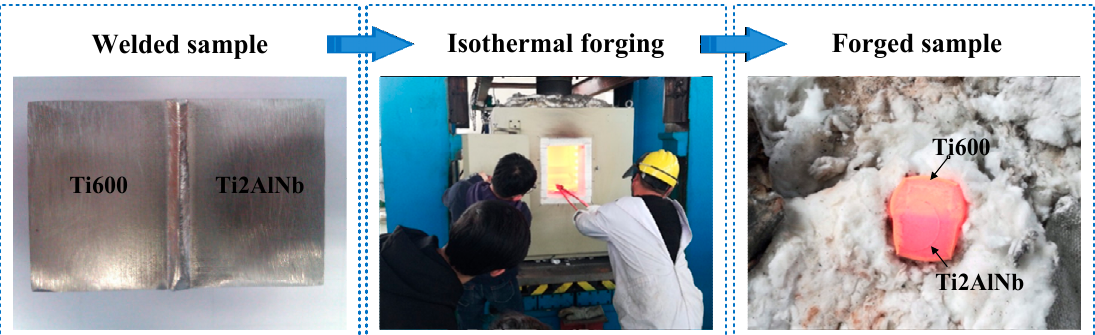
Figure 3. Flow diagram of isothermal forging.